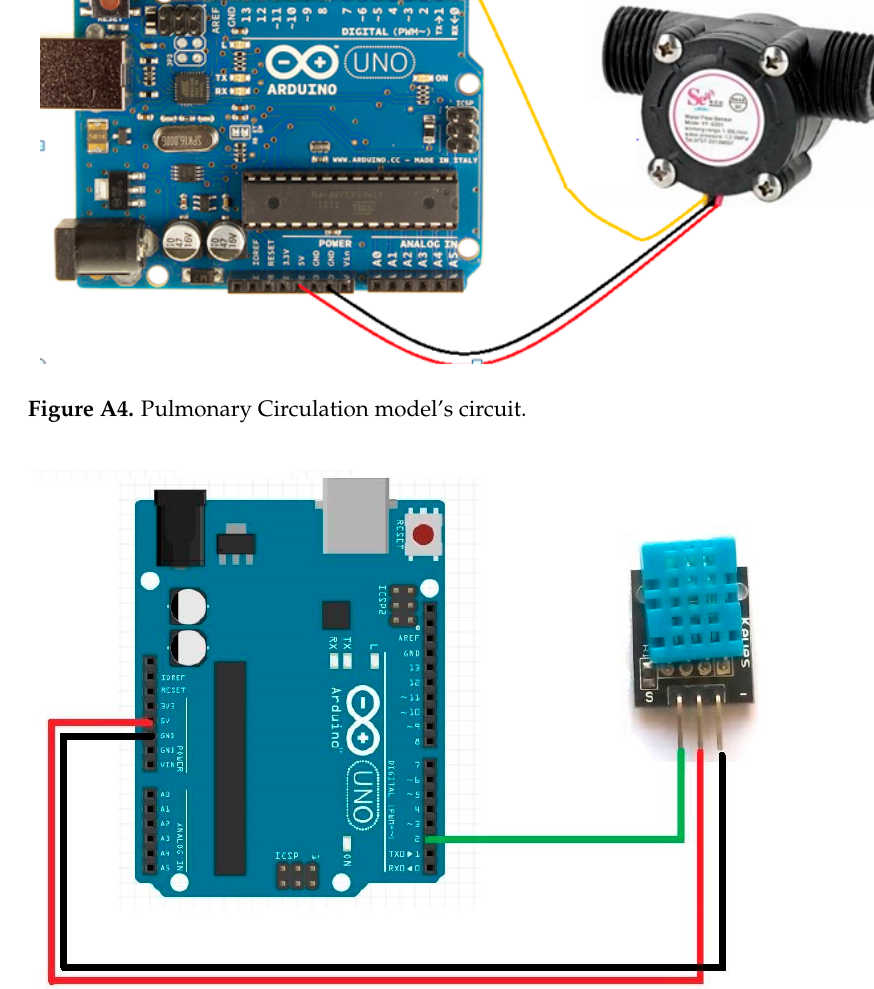
Figure A5. Moisture-sensitive hand model’s circuit.